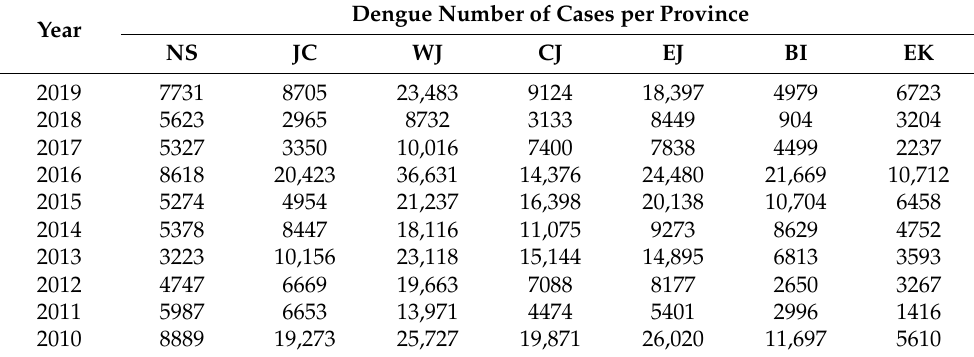
Table A2. Dengue Number of Cases per Province [3,4,33–40].